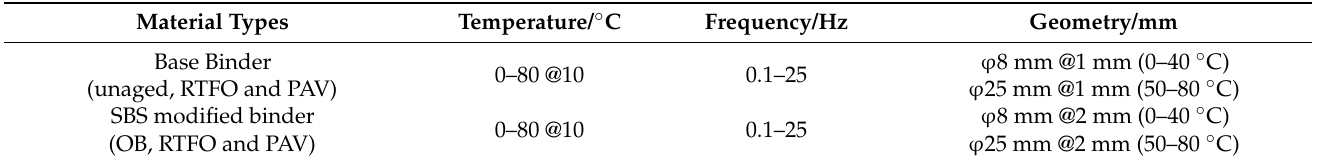
Table 2. Test parameters of frequency scanning